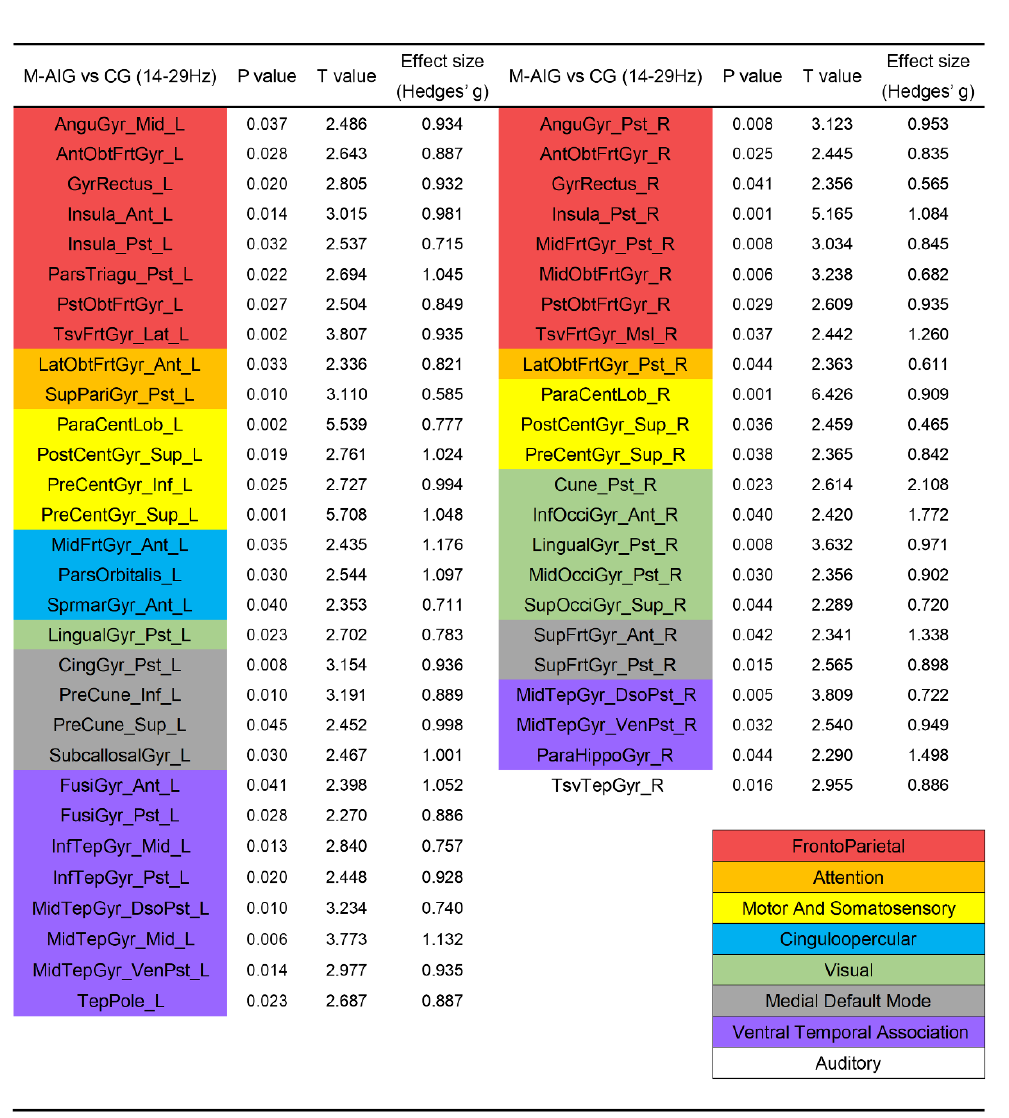
action observation-induced group; F-AIG: female action observation-induced group; CG: control group; L: left, R: right; p < 0.05, FDR corrected (for the full name of ROIs see Supplementary Table S1). Colors for functional modules: red: frontoparietal system; orange: attention system; yellow: motor and somatosensory system; blue: cinguloopercular system; green: visual system; purple: ventral temporal association; white: auditory system.